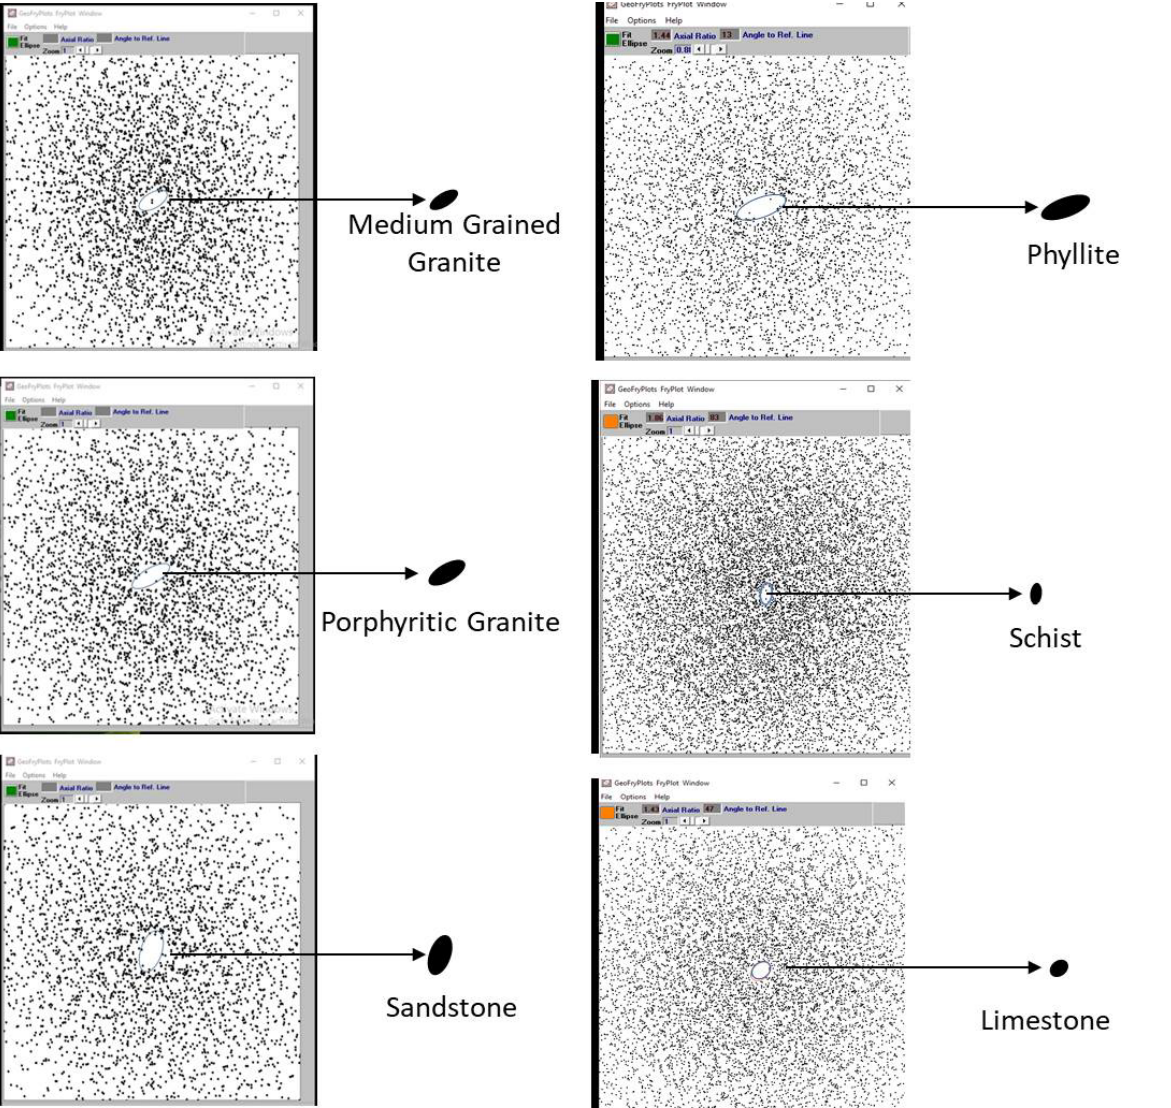
Figure 9: Fry halos obtained from respective samples within the study